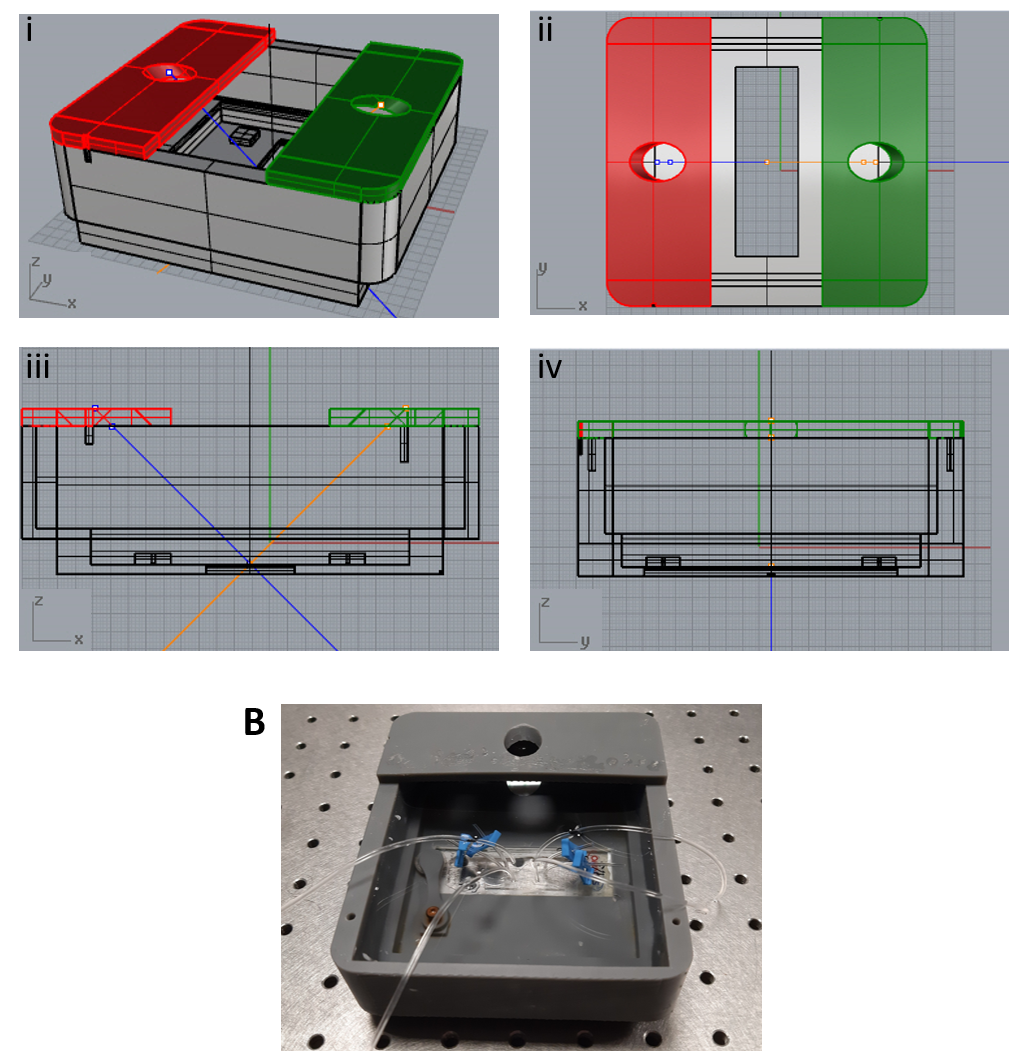
Figure 2. ( A ) Technical drawing of the insonation chamber prototype: (i) overview, (ii) top view, (iii) and (iv) lateral views. ( B ) Picture of the 3D-printed insonation